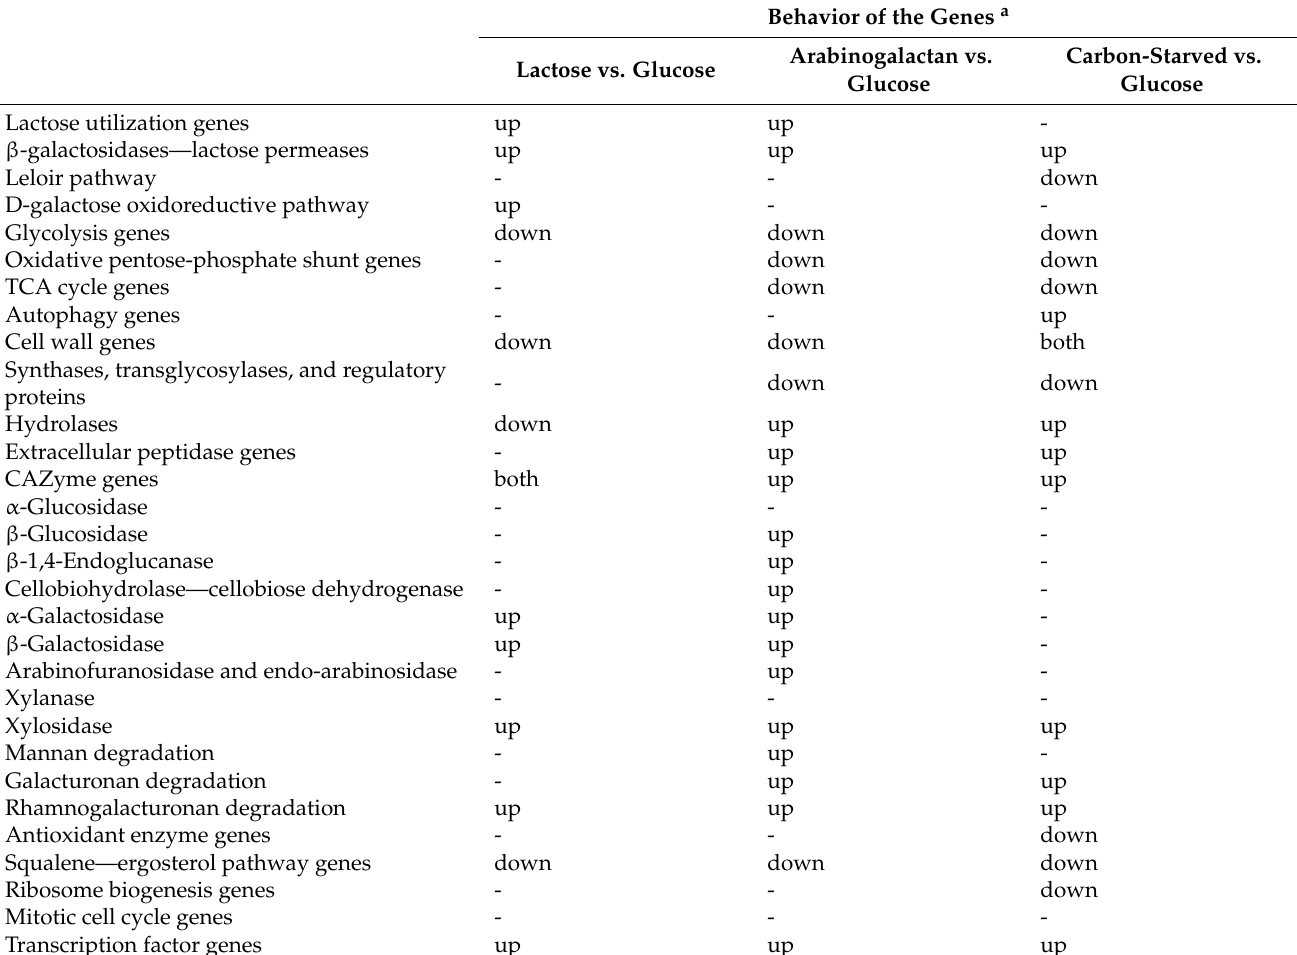
Table 3. Summary of the regulation of the selected gene groups in carbon-stressed